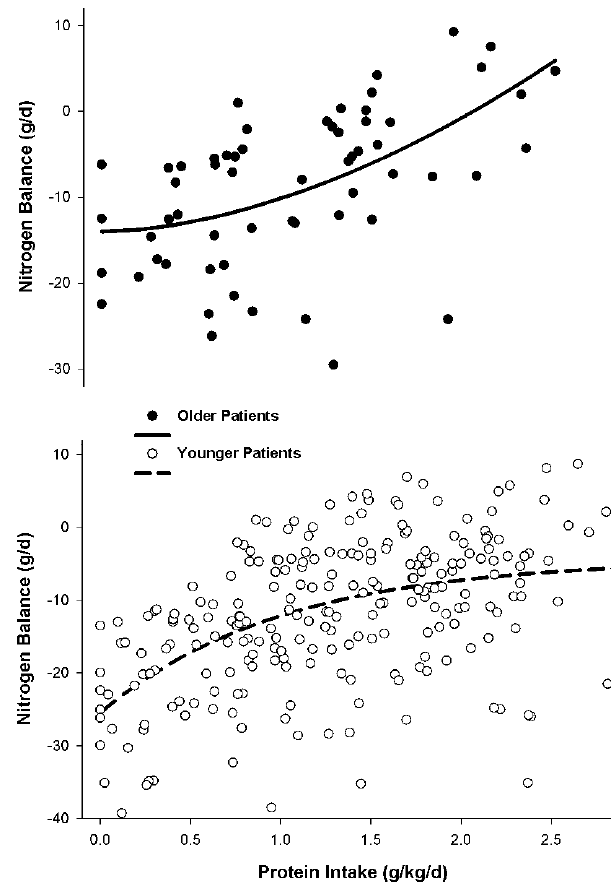
Figure 2. Nonlinear relationship between protein intake on nitrogen accretion for older and younger patients. Nonlinear correlative relationships were significant ( p < 0.001) between nitrogen balance and protein intake were r = 0.51 and r = 0.50 for the older and younger patients, respectively. Reprinted